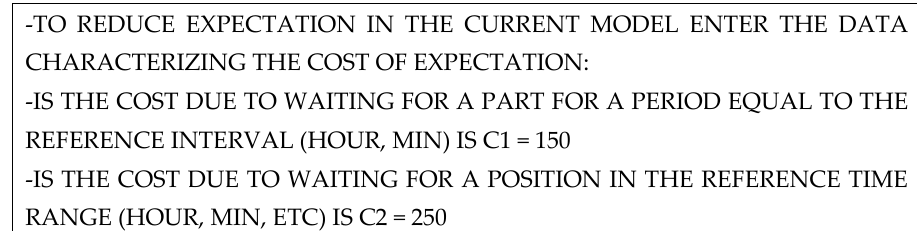
Figure 7. The input data completed with the additional elements.